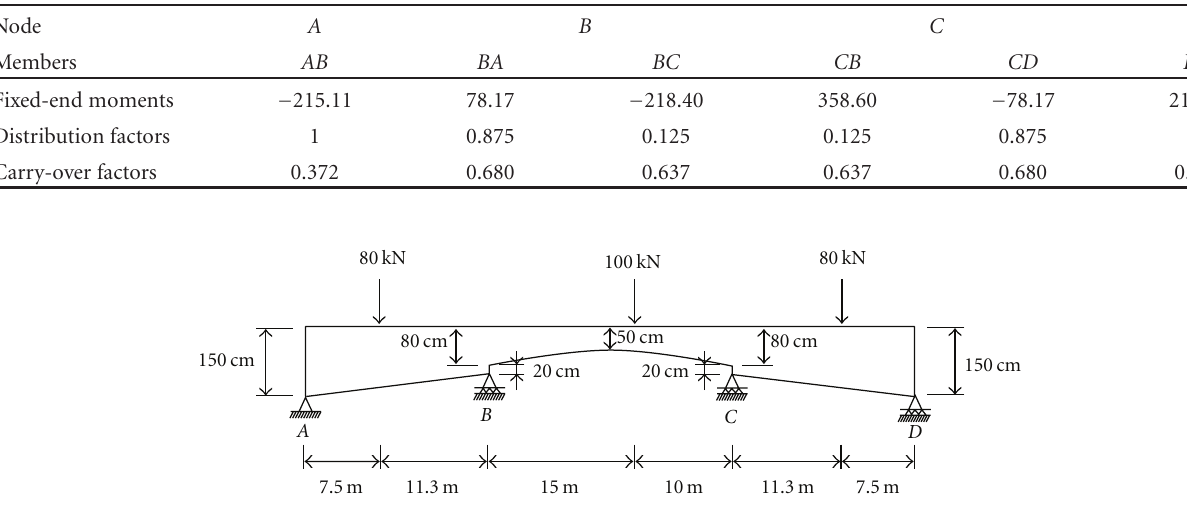
Figure 6: Continuous beam for the second example.